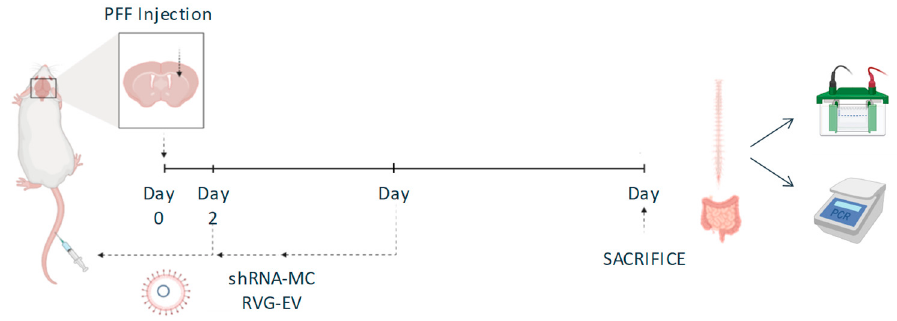
Figure 1. Experimental design of the study to evaluate the effect of anti-alpha-synuclein shRNA-MC RVG-EV therapy administrated intravenously.